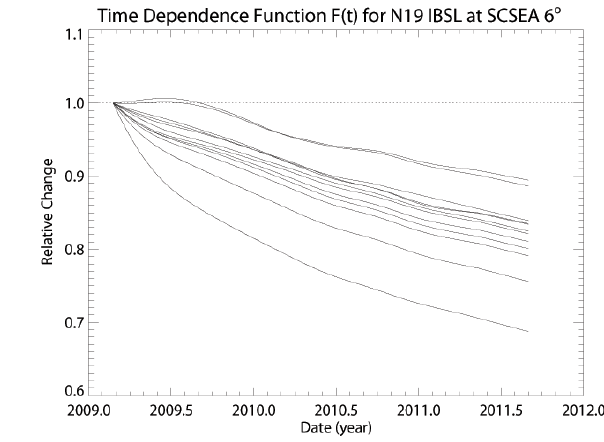
Fig. 13. Time dependence functions F(t,λ) for N19 IBSL at SC- SEA = 6 ◦ , normalized to the start of the mission. The magnitude of the overall drift monotonically increases towards shorter wave- lengths. At the end of the data record, the magnitude of F(t,λ) ranges monotonically from 0.68 at 252nm to 0.90 at